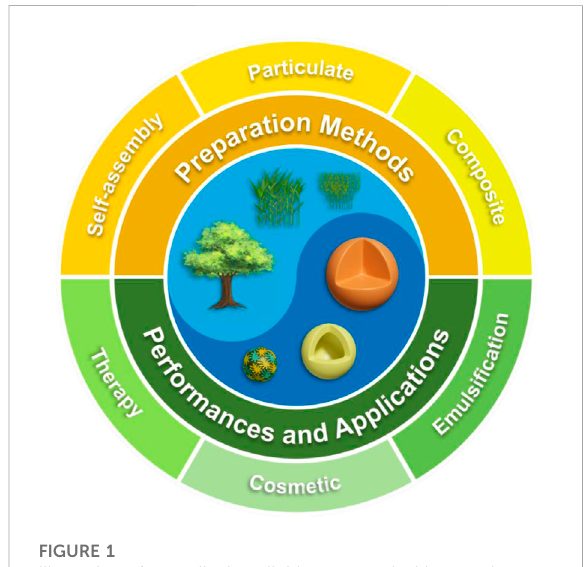
FIGURE 1 Illustration of some lignin colloids structured with several preparation methods toward signi fi cant performances and